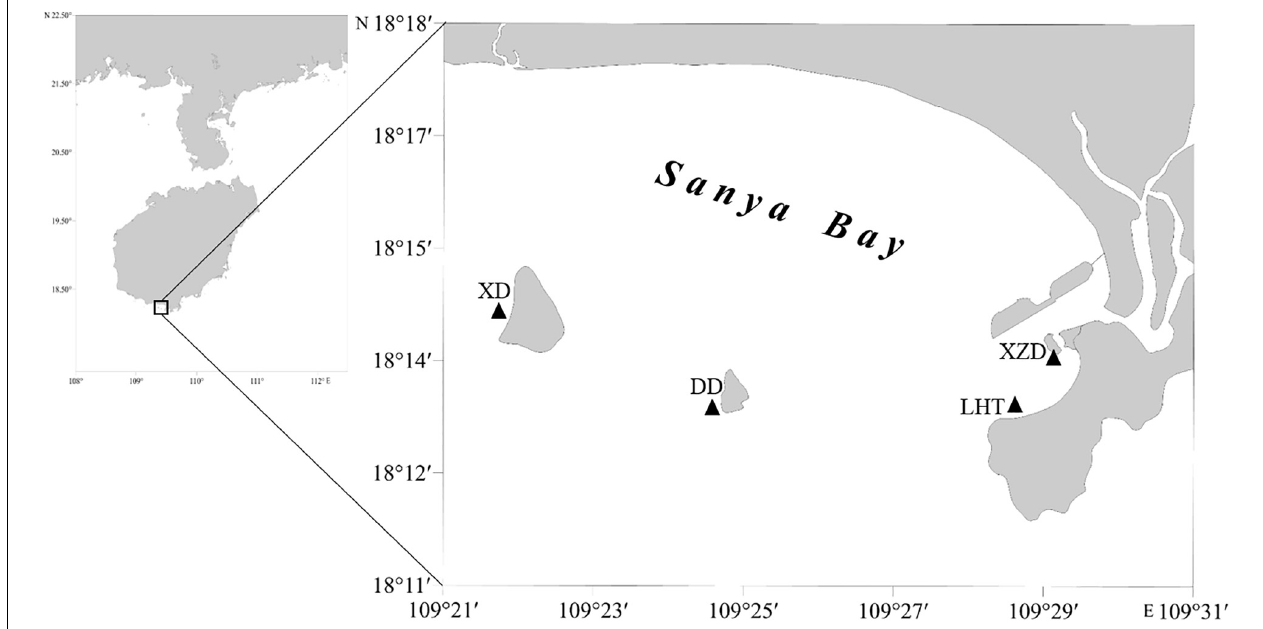
FIGURE 1 | Sample sites in Sanya Bay, China. XD, Xidao; DD, Dongdao; XZD, Xiaozhoudao; LHT,